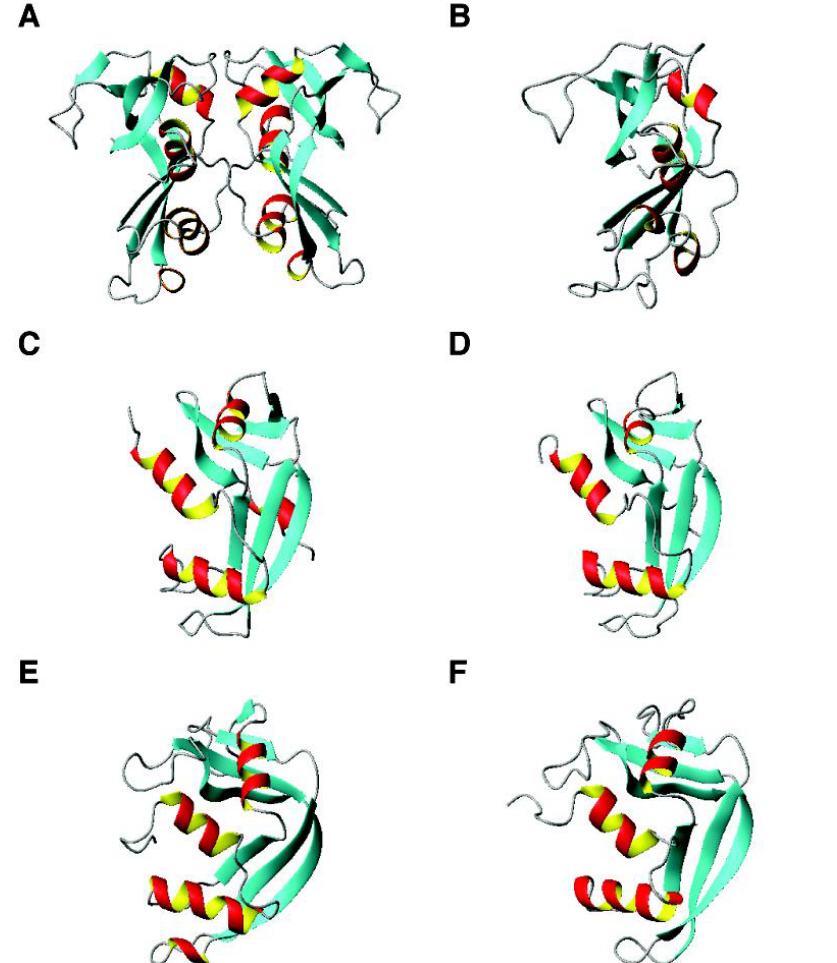
Figure 4. 3D structures of human ribonucleases with antimicrobial activity. Shown are ( A ) RNase 3 (dimeric crystal structure, PDB ID: 4A2O); ( B ) RNase 3 (NMR structure,